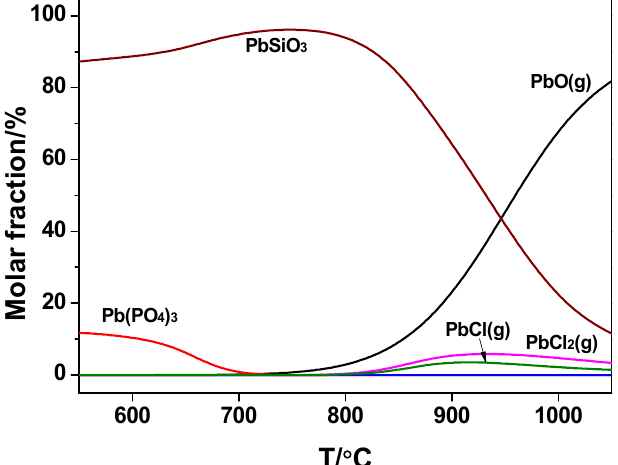
Figure 8. Effect of temperature on the distribution of Pb species in the co-combustion in thermodynamics.